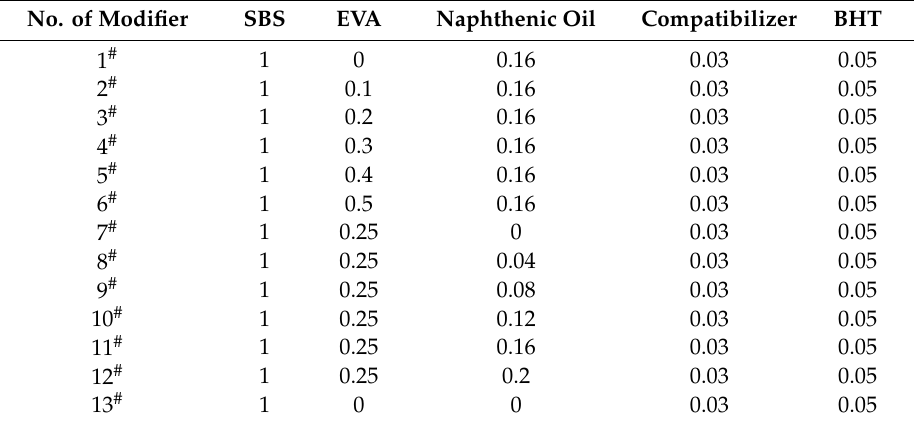
Table 3. The di ff erent kinds of direct-to-plant SBS